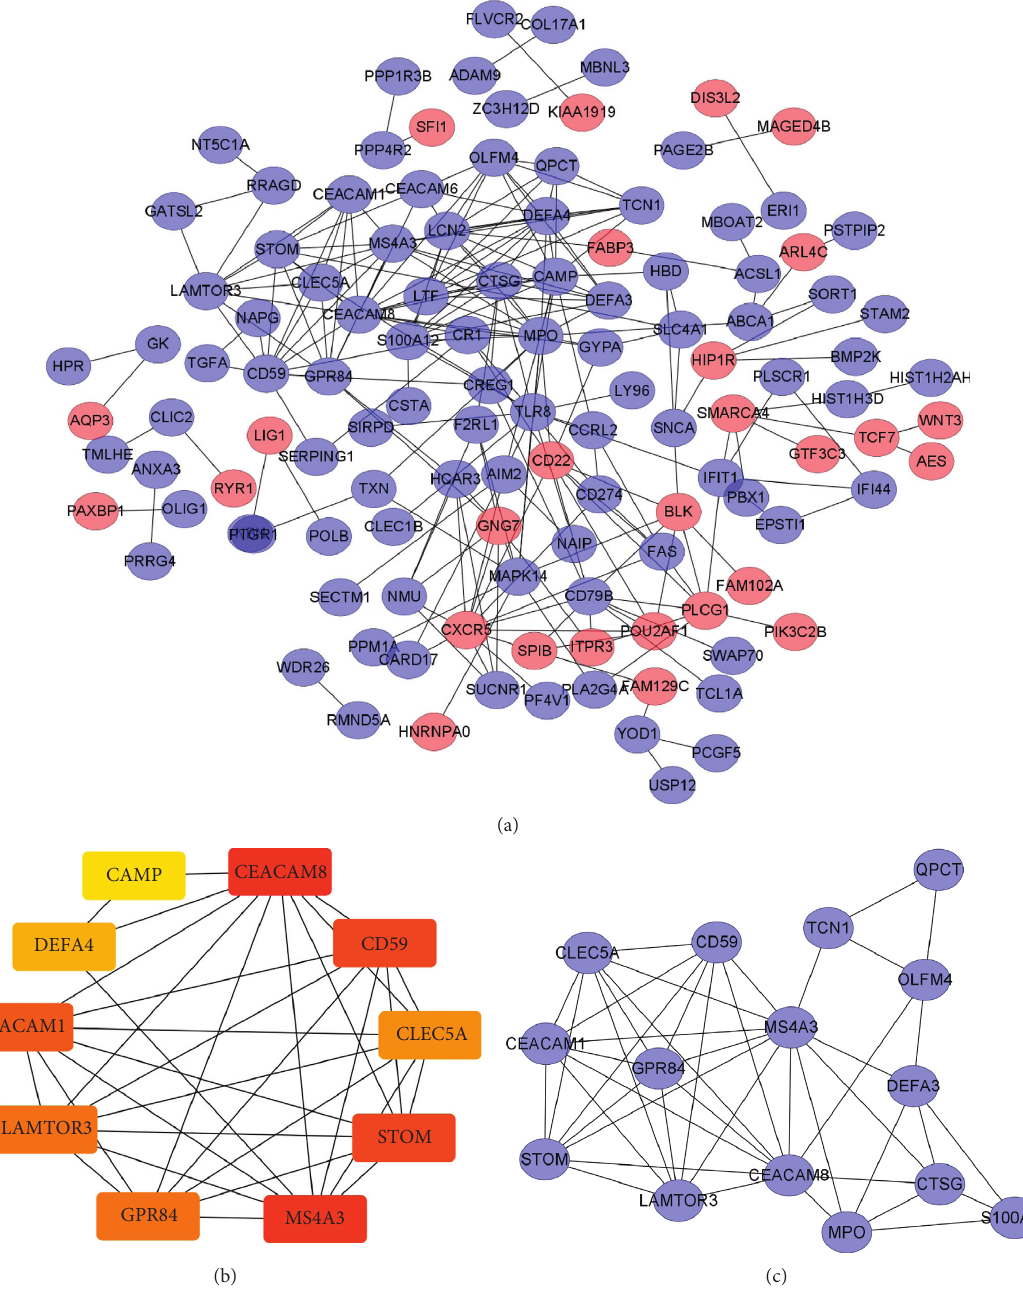
Figure 4: (a) Circular nodes show the DEGs. The blue nodes stand for downregulated DEGs, and red nodes stand for upregulated DEGs. (b) The 10 hub genes identified from the PPI network. (c) The top module extracted from the PPI network. The blue nodes stand for downregulated DEGs, and red nodes stand for upregulated